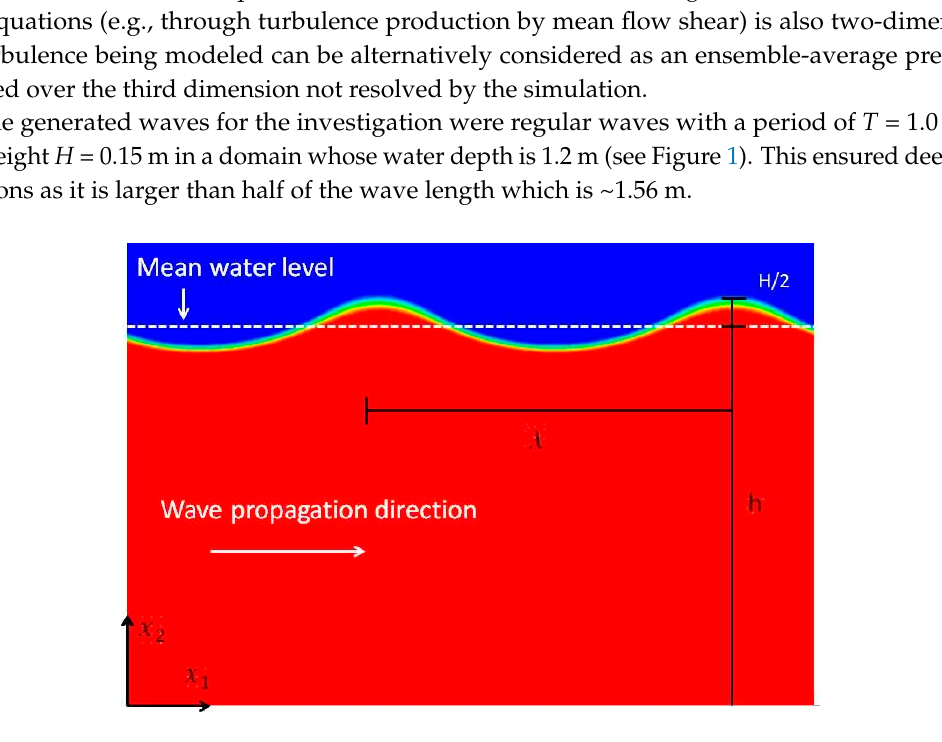
Figure 1. Details of multi-phase wave simulation. The areas colored in red represent cells with water phase (i.e., α w = 1 in Equation (7a)) and areas colored in blue represent cells with air phase (i.e., α w = 0).